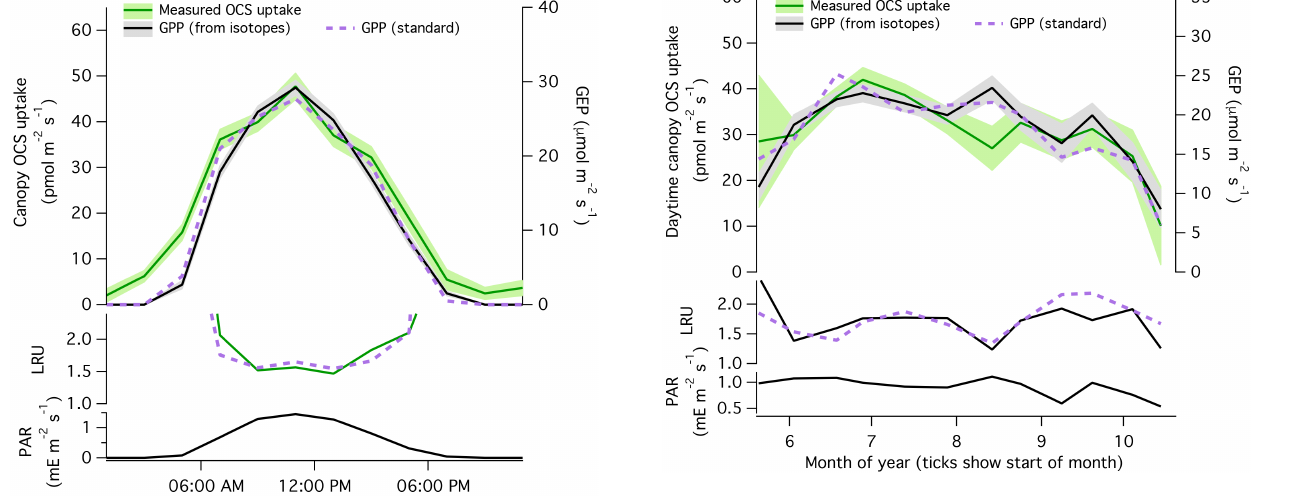
Figure 6. Composite seasonal cycles (including the years 2012 and 2013) of canopy OCS uptake and GPP, along with LRU and PAR. GPP from the isotopic and standard partitioning methods described in Wehr et al. (2016) is shown. Lines connect the mean values of each 2-week bin. Pale bands depict standard errors in the means as estimated from the variability within each